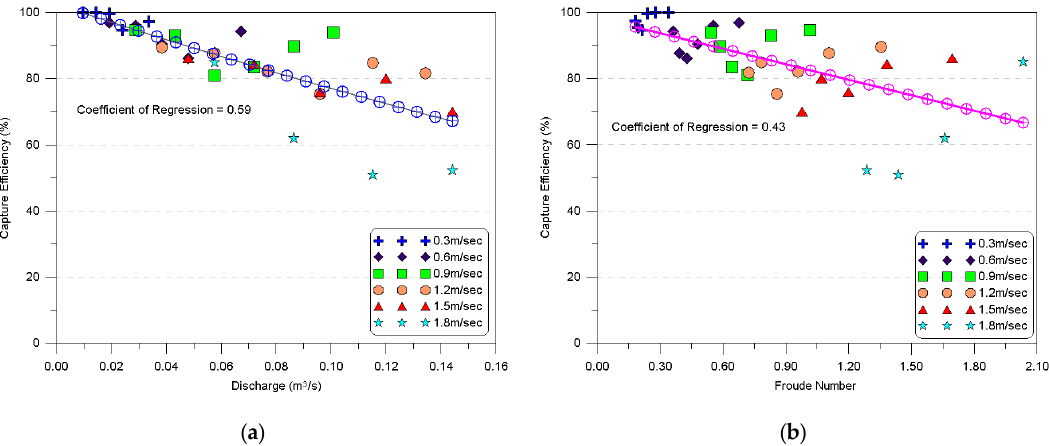
Figure 8. Capture efficiency of the driftwood capture trellis by hydraulic characteristics: ( a ) capture efficiency by discharge; ( b ) capture efficiency by Froude number.